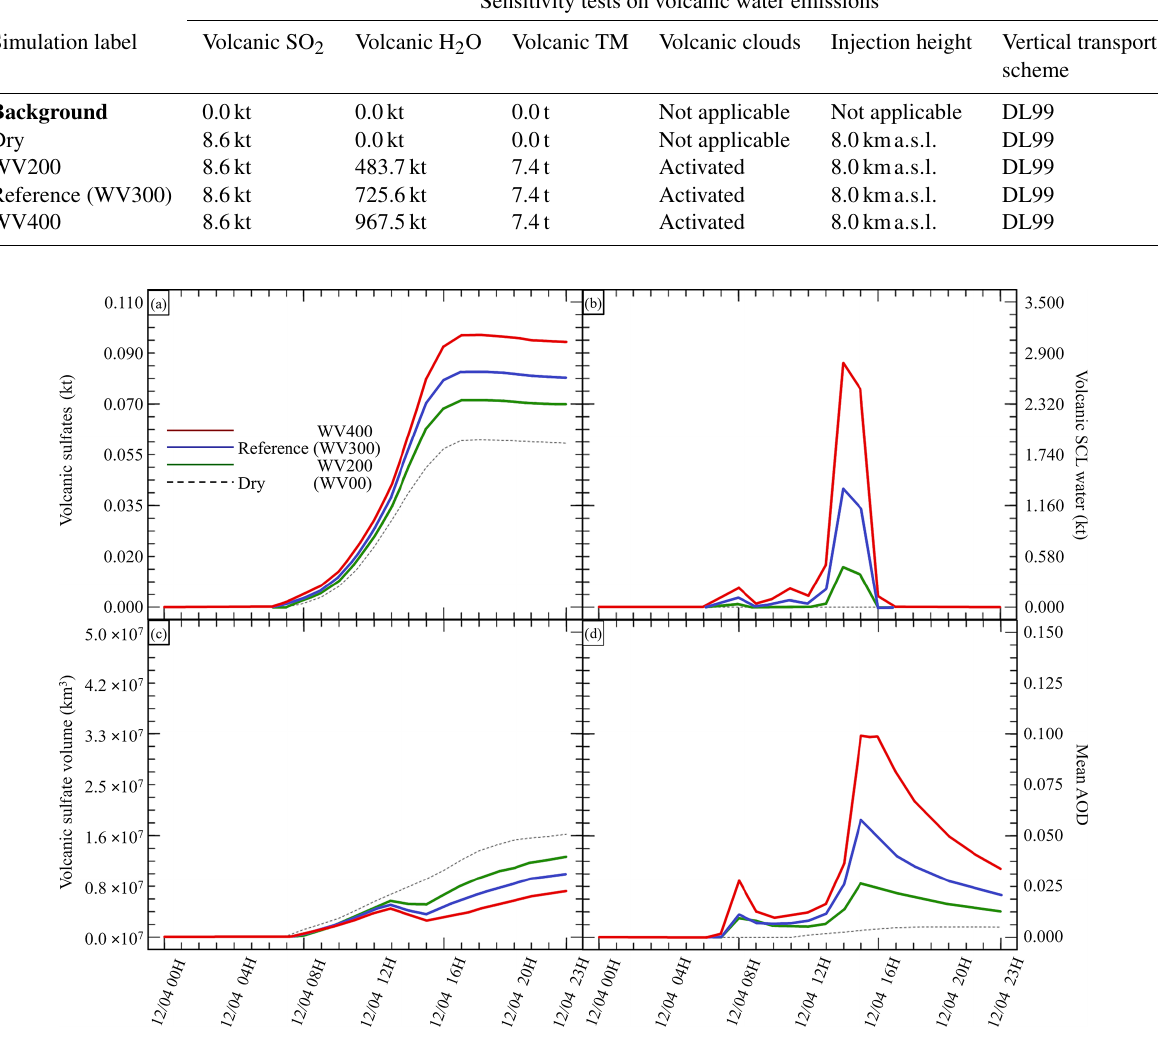
− , kt), (b) supercooled liquid water (kt), (c) the minimum 4(p) mass. The Reference simulation is the closest to a realistic 4(p)